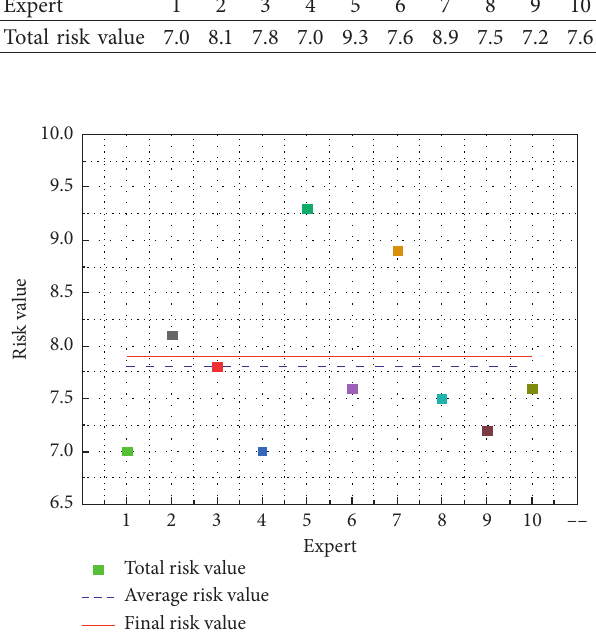
Figure 7: Total risk value of each